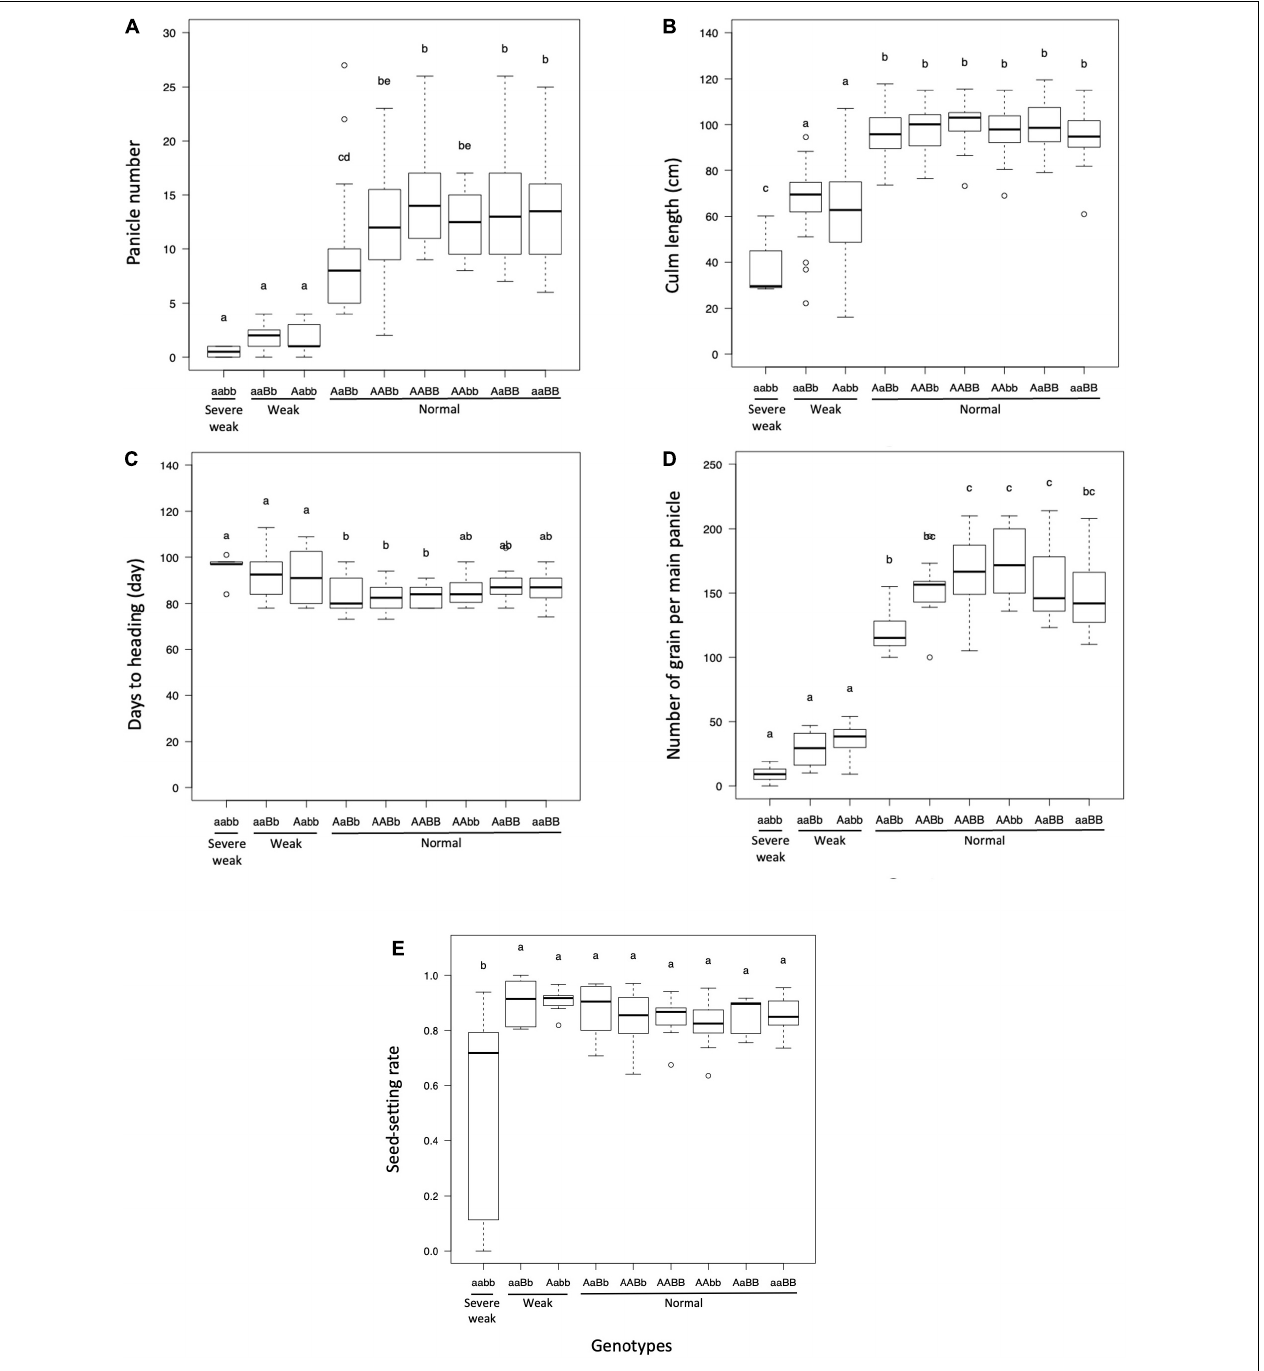
FIGURE 4 | Boxplot of evaluated traits of F 2 population in field condition: (A) panicle number, (B) culm length (cm), (C) days to heading, (D) number of grains per main panicle, and (E) seed-setting rate. Different letters in each phenotype represents significant differences among the genotypes based on one-way ANOVA followed by Tukey’s HSD test ( p <